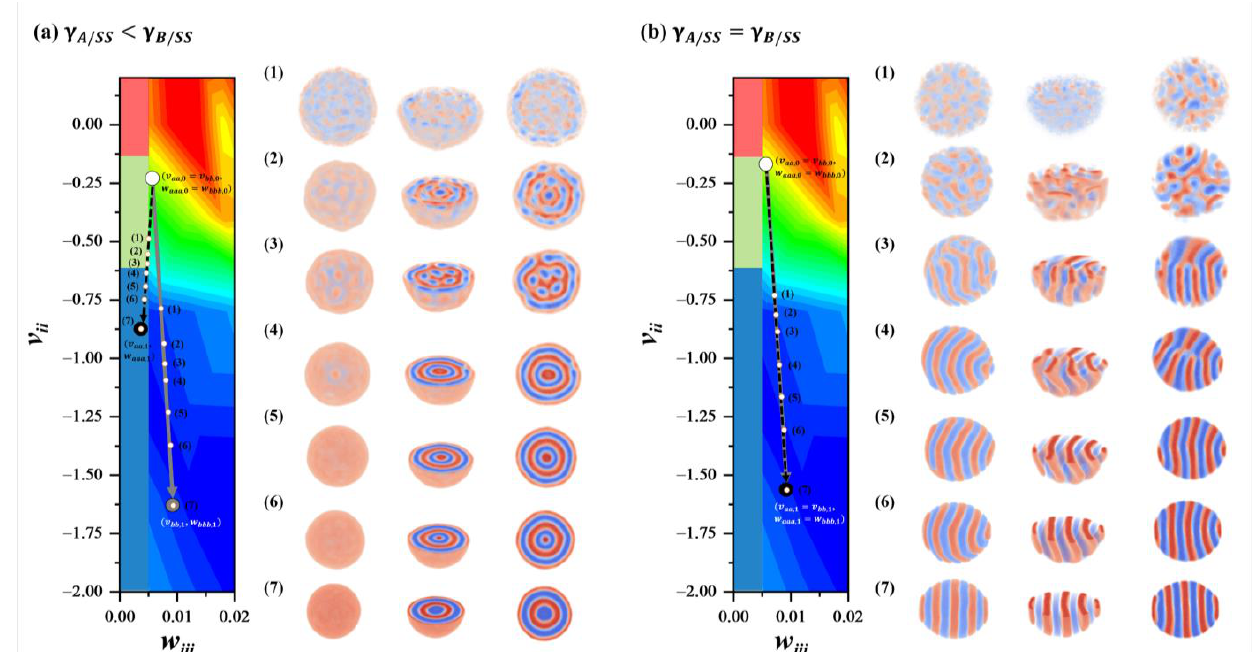
Figure 5. Morphological evolution of emulsified BCP droplets obtained from MC-G simulations. Evaporation of organic solvents from droplets to the surrounding solvent (SS) is mimicked by updating the virial coefficients on the fly. The simulation shown in ( a ) is for a droplet in which B block has a higher surface tension with the surrounding solvent compared to A, whereas in the simulation shown in ( b ), A and B have the same surface tension value. The right sides of ( a , b ) show front view (left), center-cut (middle), and 2D projection of center-cut (right) view of the morphologies observed at different stages of the evaporation process labeled as numbers ranging from 1 to 7. On the left sides of ( a , b ), the virial coefficients corresponding to each of the morphologies are marked on the ( v , w ) colormap of scaling exponents. The virial coefficients are chosen to be on the line connecting the points φ P = 0 and φ P = 1; the virial coefficients for φ P = 0, labeled ( v ii,0 , w iii,0 ) for species i , correspond to a dilute condition in which an organic (good) solvent is abundantly present in a droplet and the coefficients for φ P = 1 correspond to the densely collapsed polymer under a poor surrounding solvent (labeled ( v ii,1 , w iii,1 ) for species i ). The virial coefficient values are then linearly ramped up from their initial values to the final values at φ P = 1 during the course of the simulation, which resembles the evaporation of organic solvent inside the